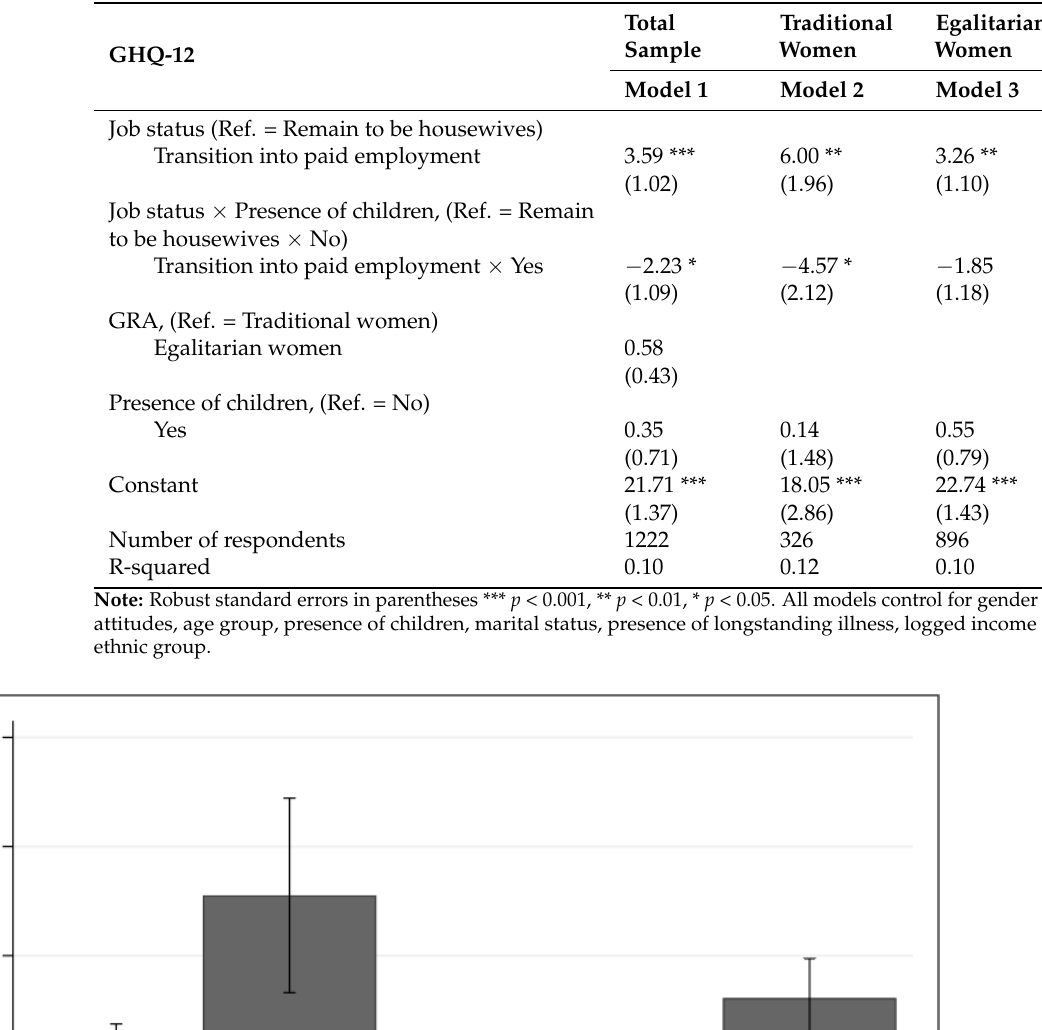
Table 3. Ordinary least squares (OLS) regressions predicting the moderation effects of the presence of children in the impact of transitioning from being a housewife to paid employment on women’s mental health.